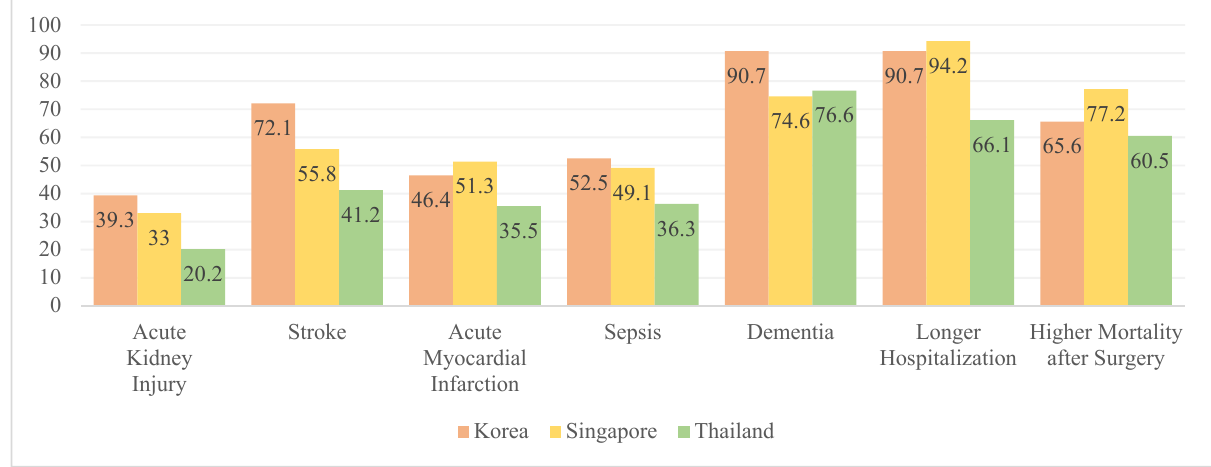
Figure 3. Perceived morbidity and mortality associated with postoperative delirium among the survey respondents.